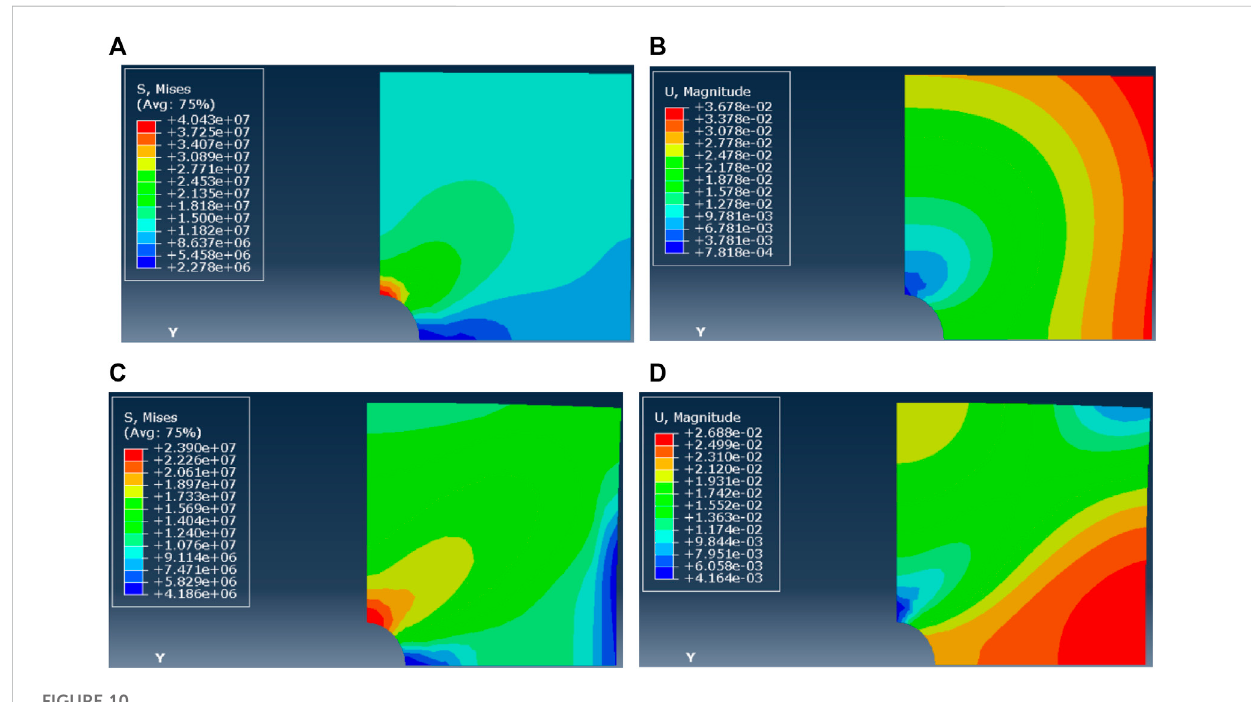
FIGURE 10 (A – D) Mises stress and displacement of borehole shrinkage after reaming ( Δ P =15 MPa, n= 1). Mises stress and displacement of borehole shrinkage after reaming ( Δ P = 15 MPa, n = 5)